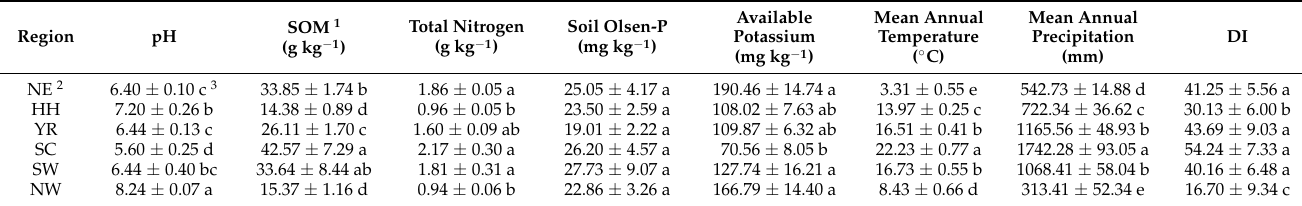
Table 1. Summary of experimental site information at different regions.